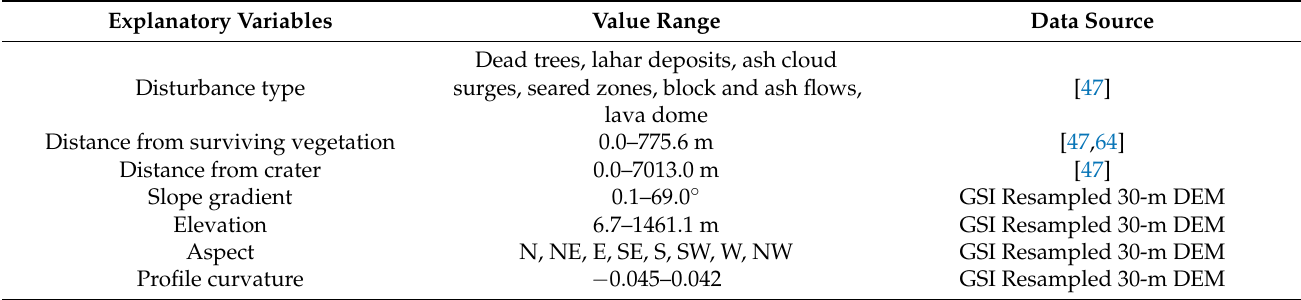
Table 1. Summary of explanatory variables used for regression tree analyses. The value ranges are from our analysis of the explanatory variables in QGIS.